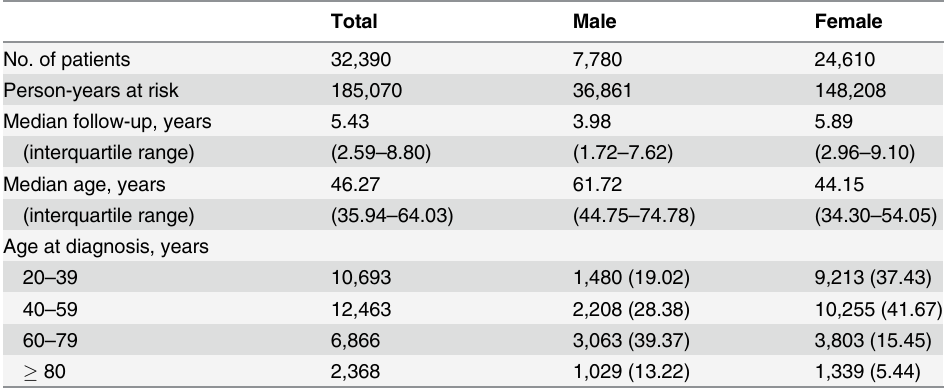
Table 1. Patient